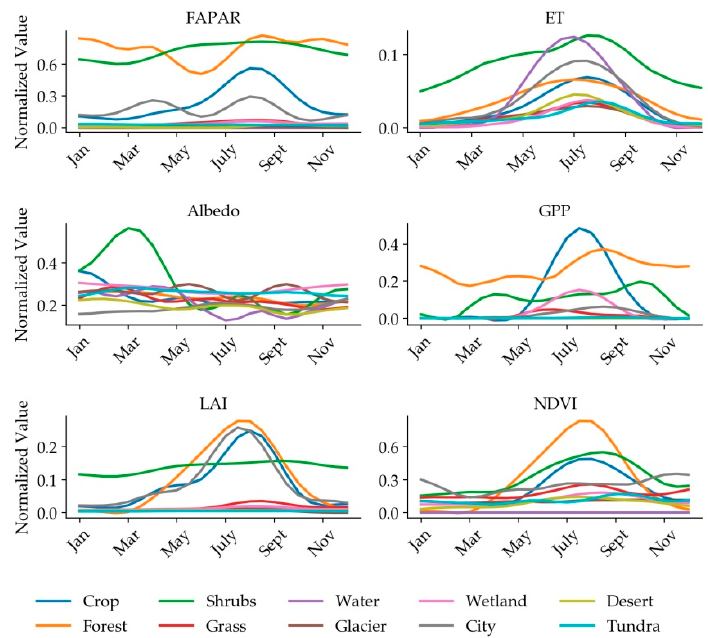
Figure 9. Differences in time series between six quantitative remote sensing products in 10 categories.